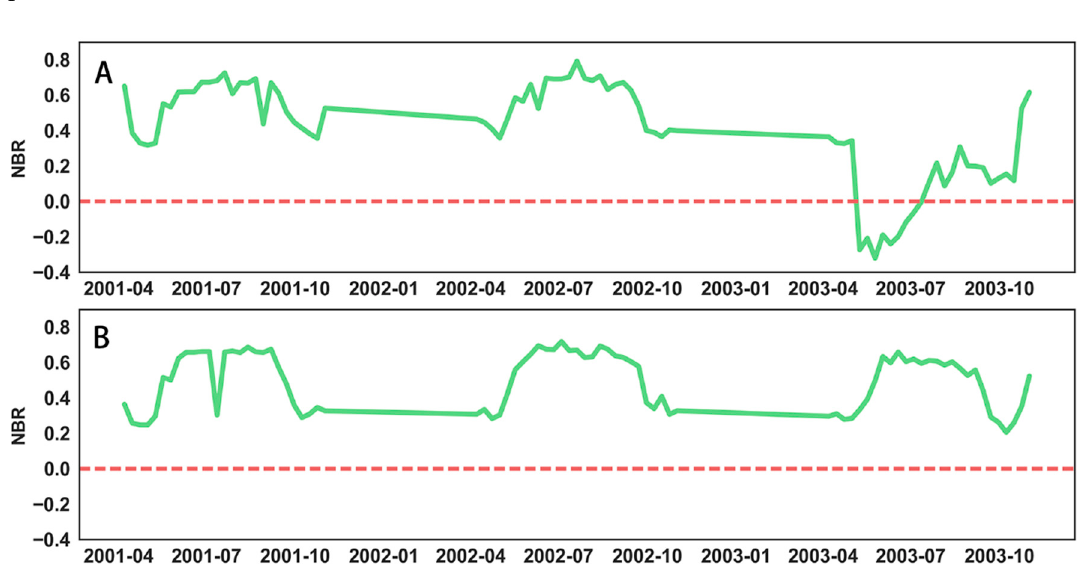
Figure 4. Difference between the NBR anomalies for burned ( A ) and unburned ( B ) areas in 2003. The green curve is the value of NBR, and the red dotted line is the horizontal line when NBR is zero.